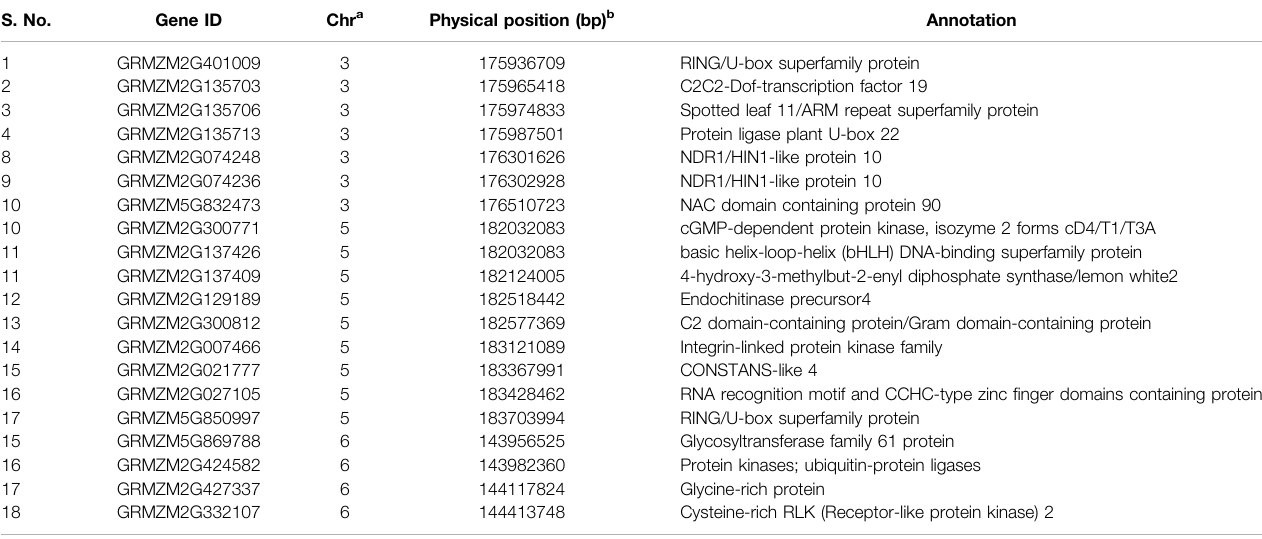
TABLE 4 | Most likely candidates for qDMR3.1 , qDMR5.1 , and qDMR6.1 on chromosome 3, 5, and 6 S.